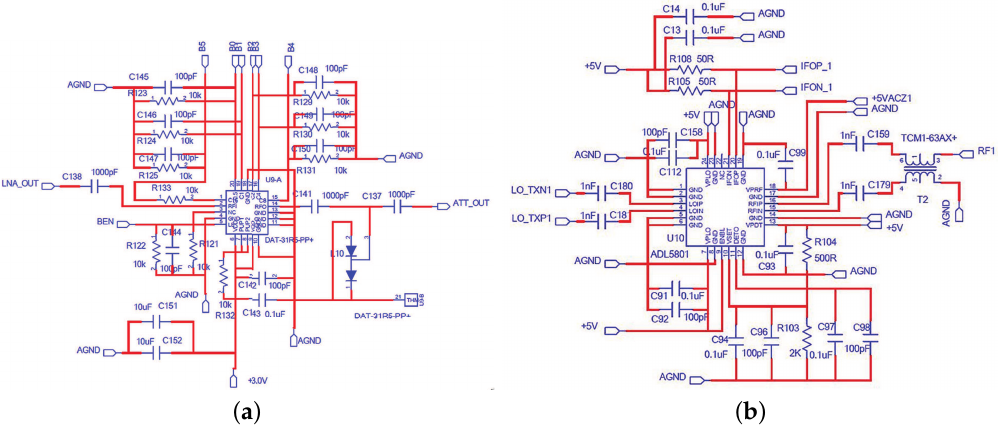
Figure 7. The circuit diagram of attenuator ( a ) and modulator ( b